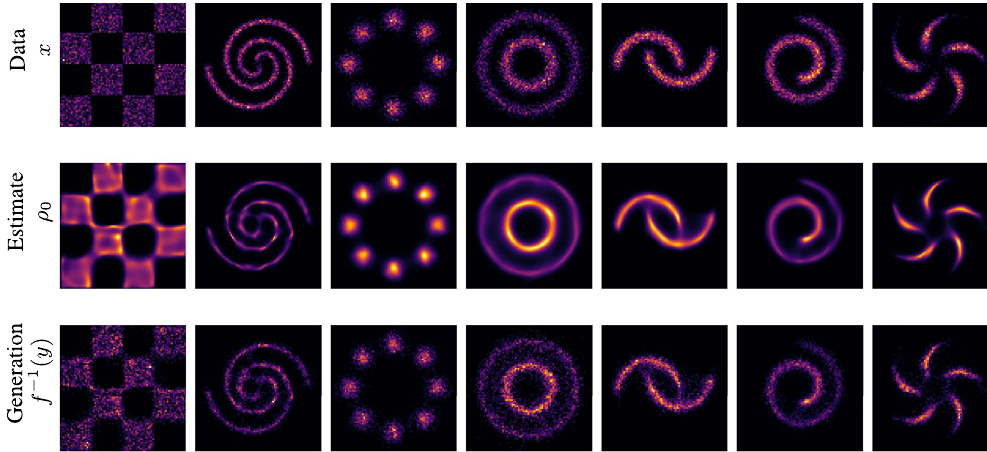
Figure 2. Density estimation on 2D toy problems using five JKO-Flow iterations. Top: samples from the unknown distribution ρ 0 . Middle: density estimate for ρ 0 computed by inverting the flow through the five iterations of JKO-Flow from ρ 1 via Eq. (2). Bottom: samples generated by inverse JKO-Flow through five iterations where y has density ρ 1 .